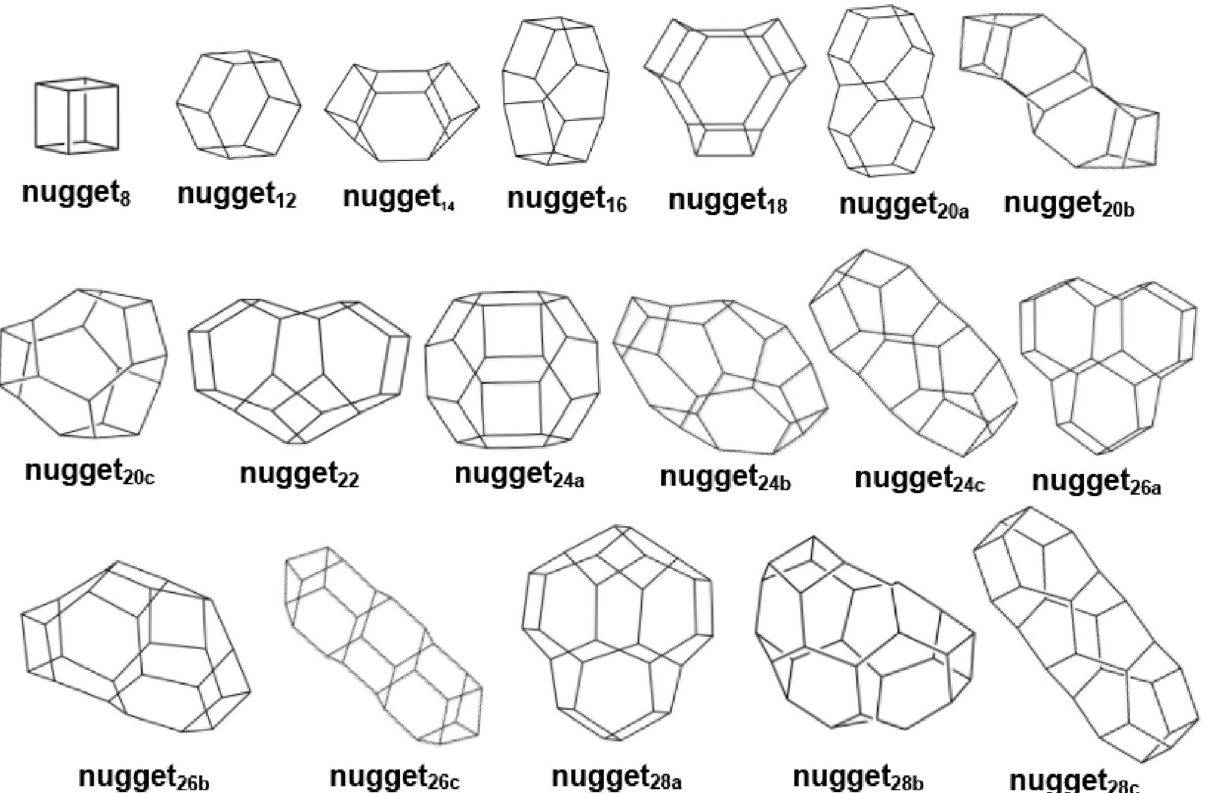
Figure 4. Chemical structures of the 18 nuggets generated by the Blink software.